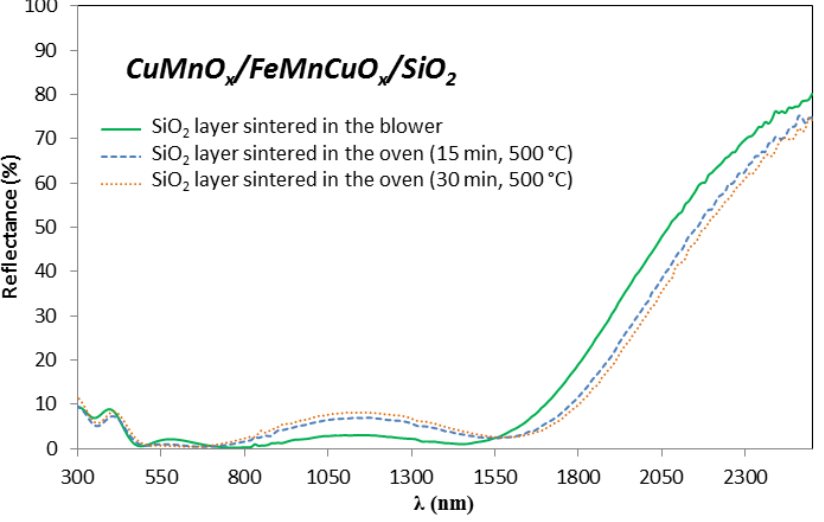
Figure 5. Influence of the sintering process of SiO 2 coating on the hemispherical reflectance spectra of the absorber Al/CuMnOx/CuFeMnOx/SiO 2 .